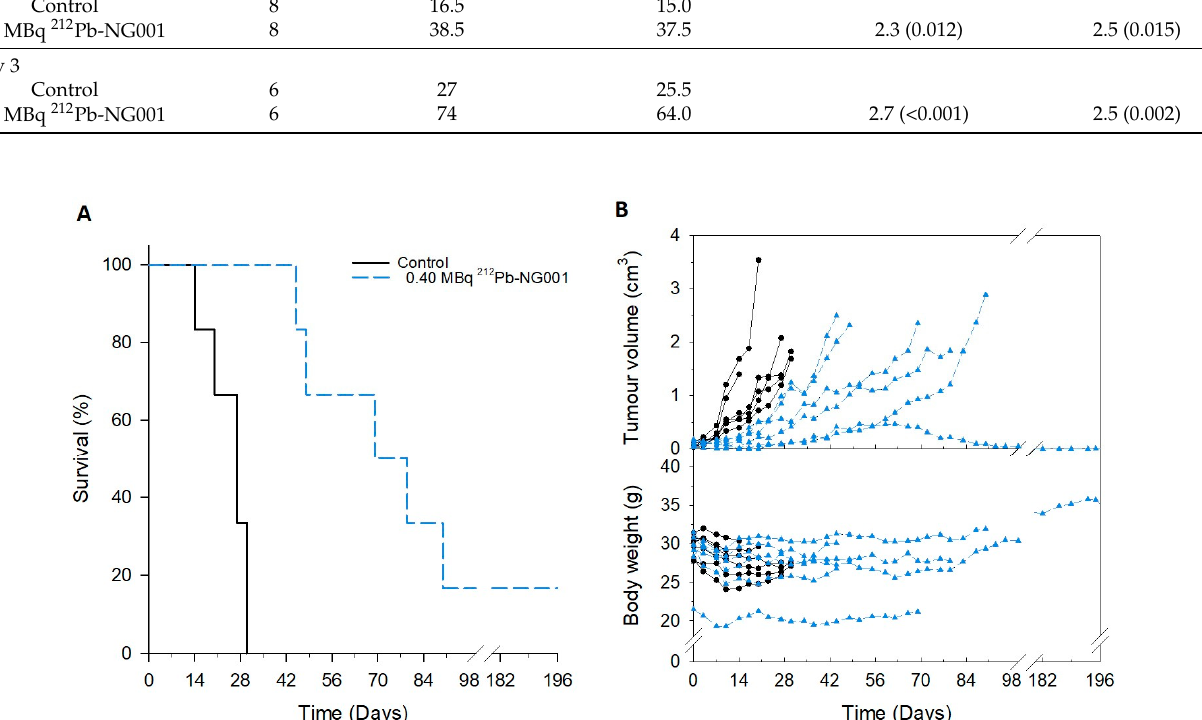
Figure 3. Survival ( A ) and changes in tumour volume and body weight ( B ) of athymic nude mice bearing prostate C4-2 tumours treated with saline or 0.40 MBq of 212 Pb -NG001. Survival was estimated by Kaplan–Meier survival analysis followed by the log-rank test by pairwise comparisons. In ( B ), each line represents one mouse (only the largest tumour is shown), N = 6 mice per group.